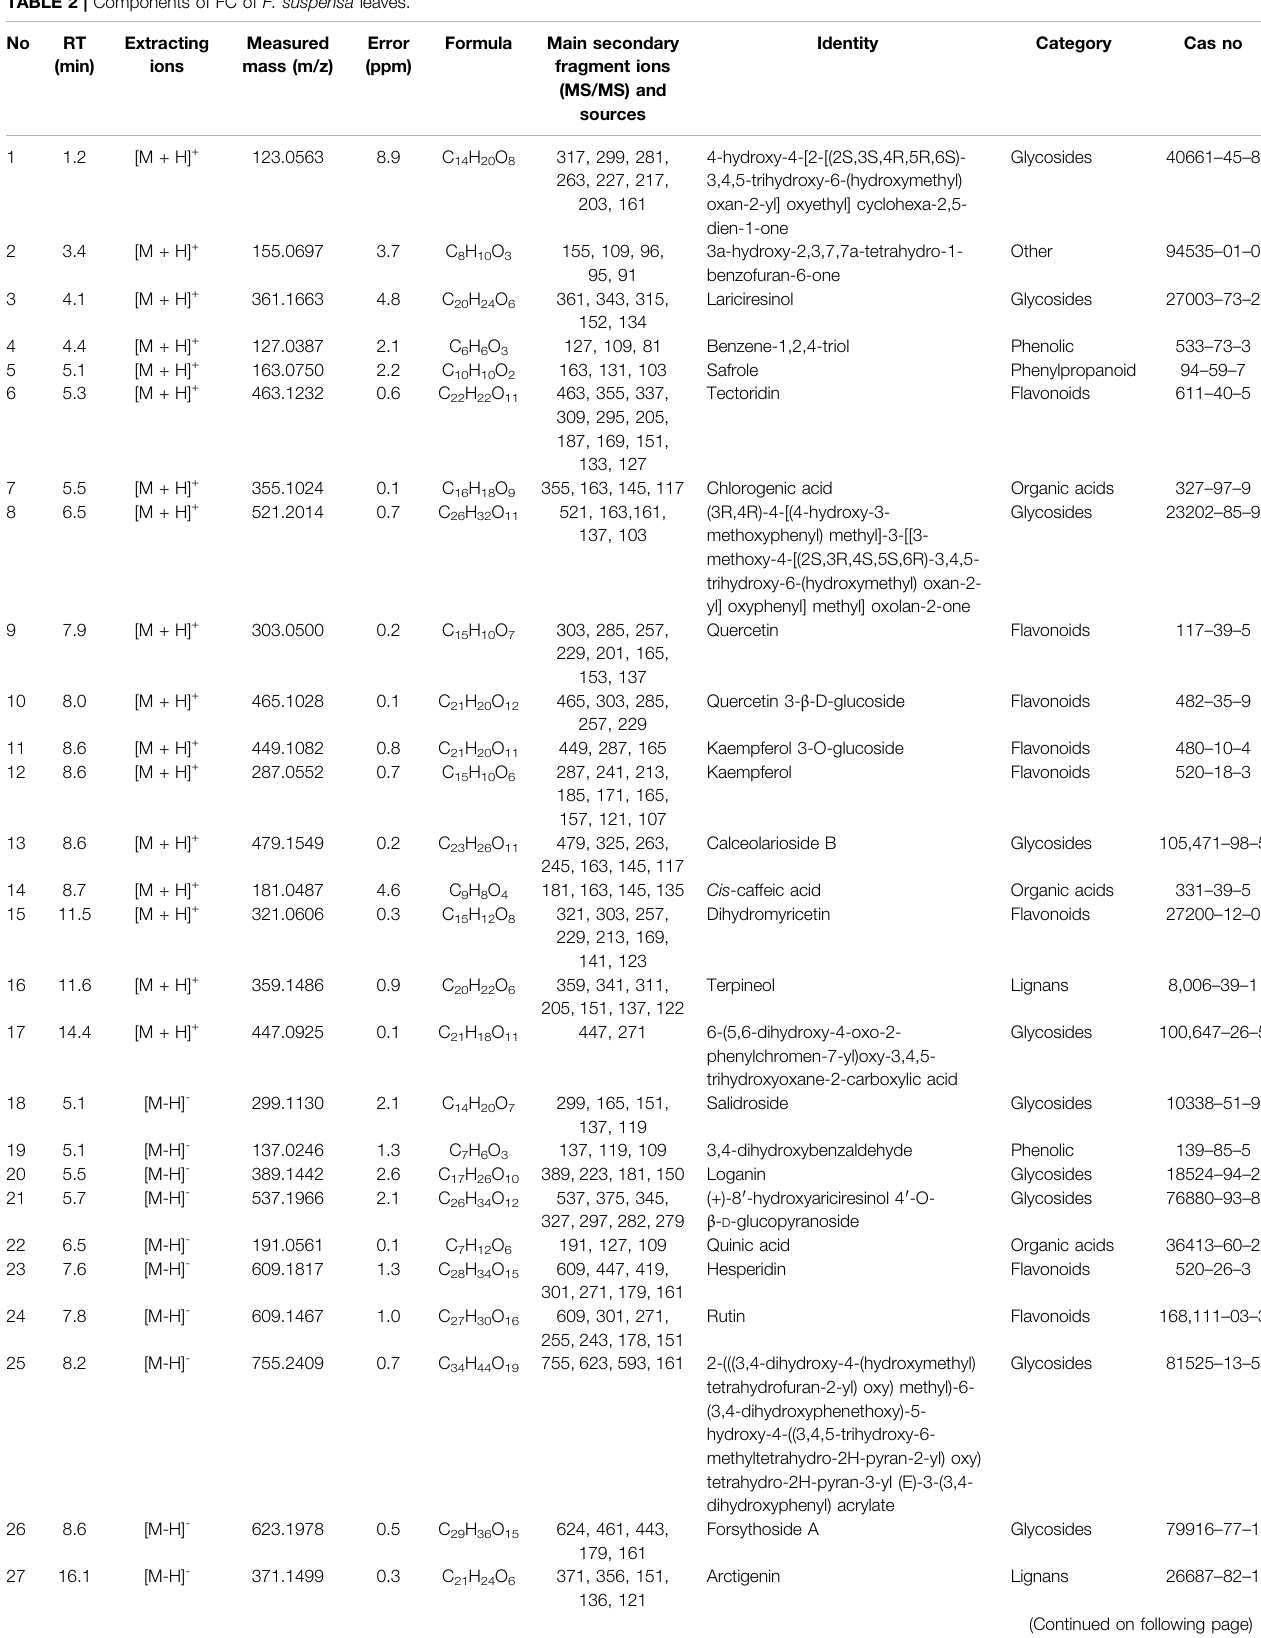
TABLE 2 | Components of FC of F. suspensa